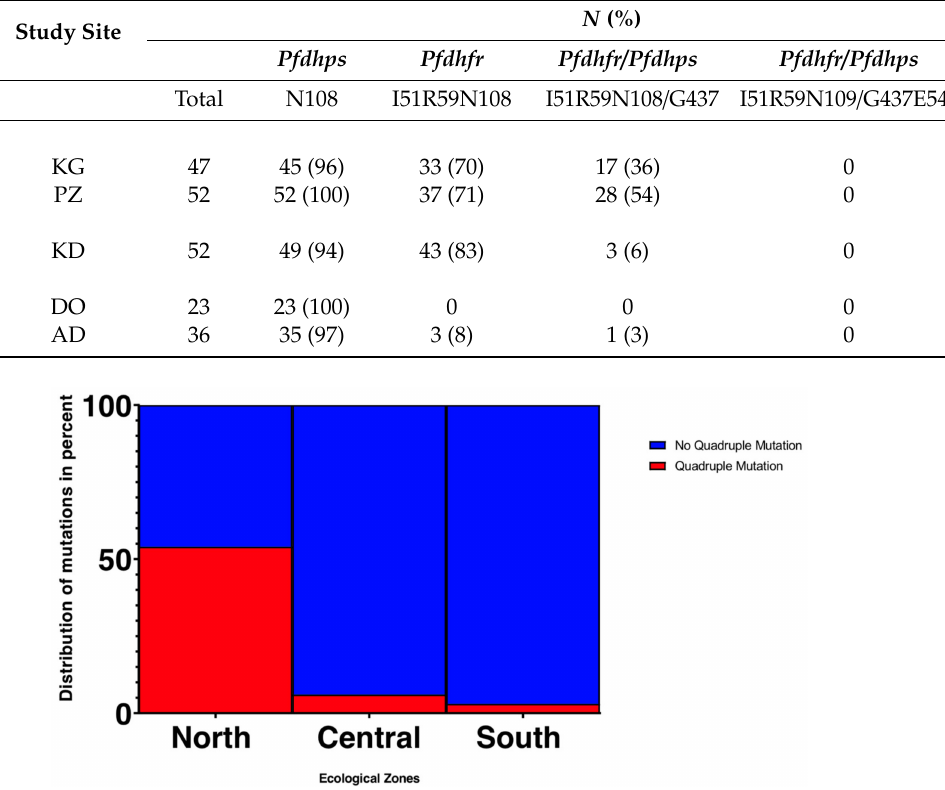
Figure 3. Frequency of the quadruple mutation pfdhfr N51I / C59R / S108N, pfdhps A437G across the di ff erent ecological